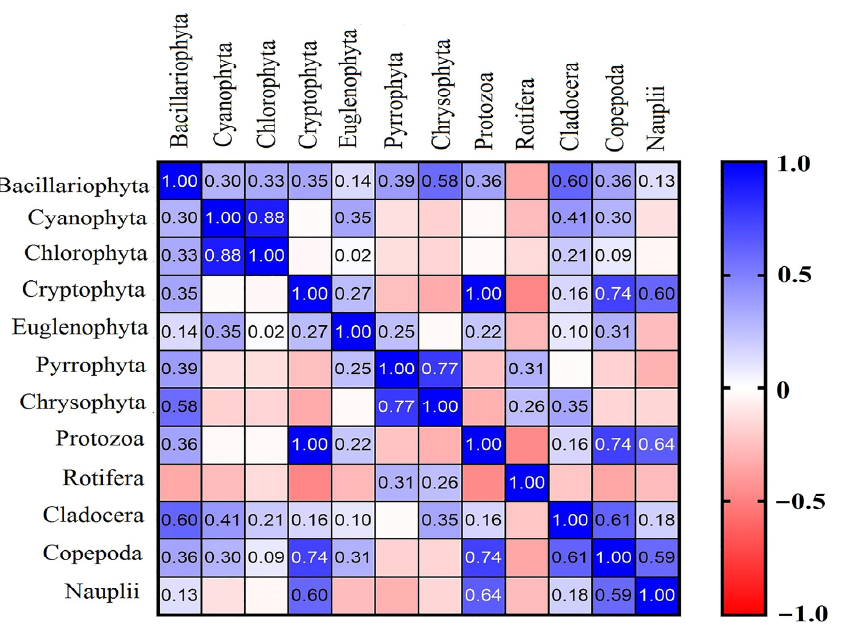
Figure 5. Pearson correlation analysis of the abundance of phytoplankton and zooplankton groups. The color represents the values of Pearson correlation coefficient. Table 2. Correlation coefficient of Pearson correlation of phytoplankton and zooplankton groups.